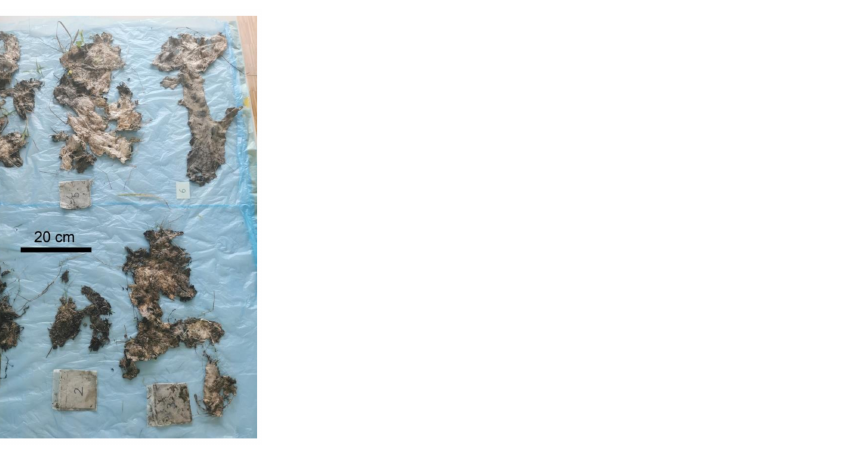
Figure 5. Photographs of samples from prototype 1–6 after 61 weeks of outdoor weathering.